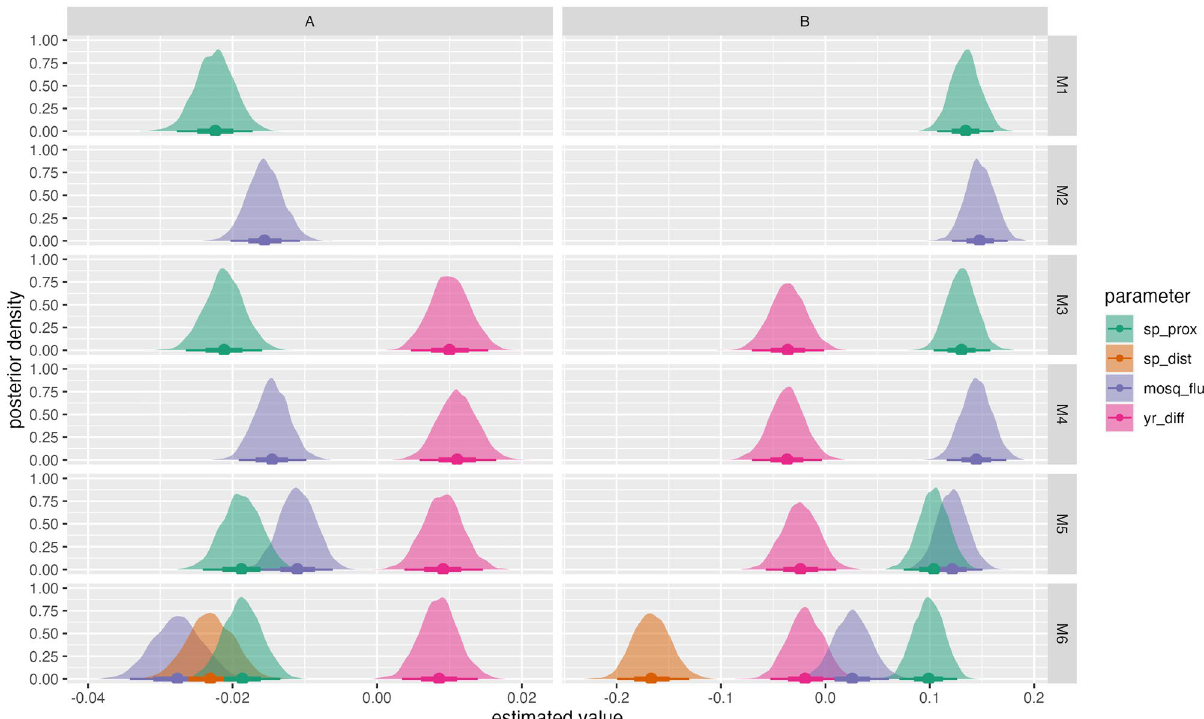
which samples were taken) on the beta mean ( μ ) parameter ( A ) and on the zeros ( B ) in the zero-inflated beta regression models. Parameters are estimated from a set of Bayesian multilevel zero-inflated Beta regressions with multiple-membership random intercepts for the samples and sampling years represented in each